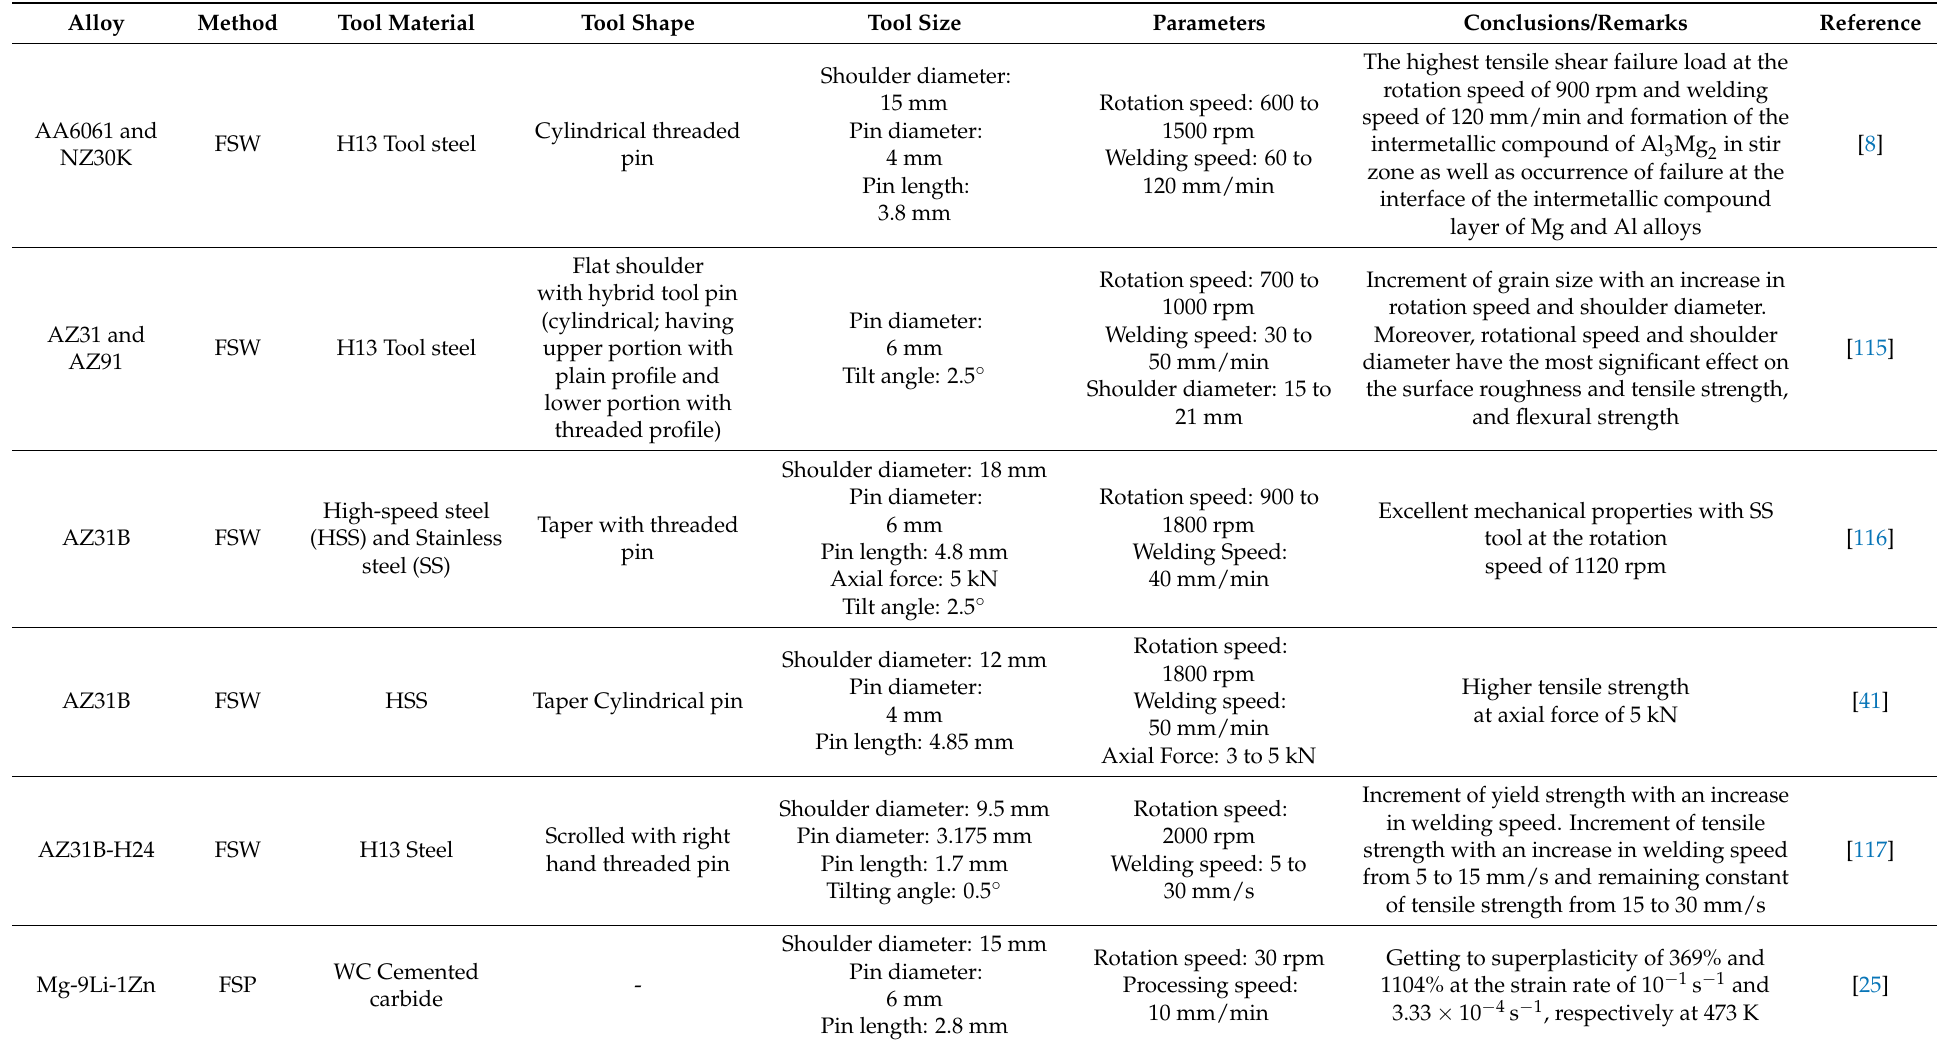
Table 5. Brief summary of the work carried out regarding parameters affects FSW and FSP techniques for Mg-based